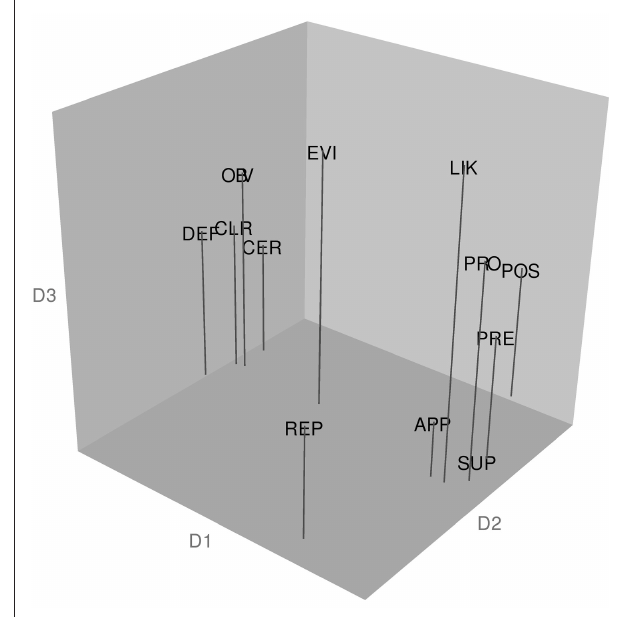
FIGURE 4 | Configuration of target adverbs in the Canadian sample and the results of a hierarchical cluster analysis of the